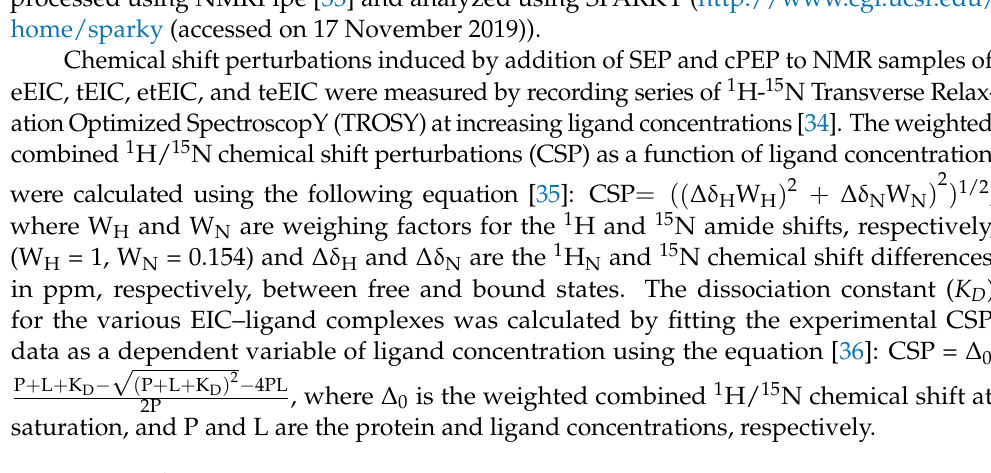
tEI; Figure S2: NMR spectra of etEIC and teEIC in the absence and in the presence of SEP or cPEP; Figure S3: Residue-specific r.m.s.f. values in PC 1, PC 2, and PC